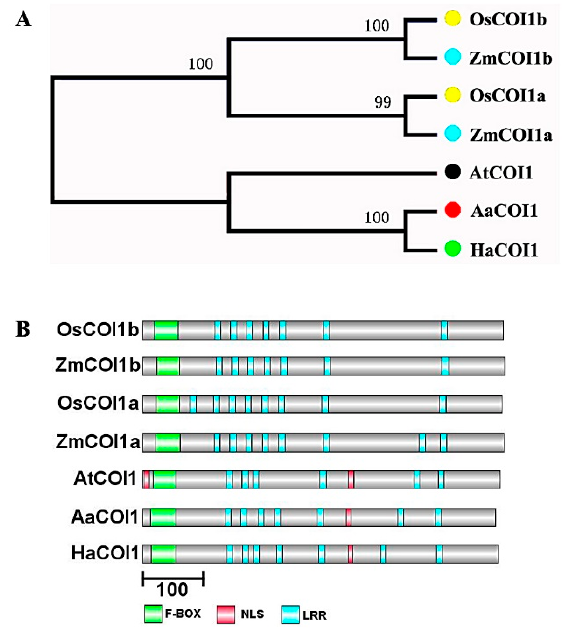
Figure 1. Phylogenetic tree COI1 paralogs ( A ) in Artemisia annua, Helianthus annuus, Oryza sativa, Zea mays and Arabidopsis thaliana, and their sequences ( B ). The relationships were analyzed for deduced full-length amino acid sequences using MEGA7 by using the Maximum Likelihood (ML) method with Partial deletion and Poisson model, and a Bootstrap test of 1000 replicates for internal branch reliability. Bootstrap values were shown near the nodes. Abbreviations: Artemisia annua (Aa) , Helianthus annuus (Ha) , Oryza sativa (Os) , Zea mays (Zm), and Arabidopsis thaliana (At).